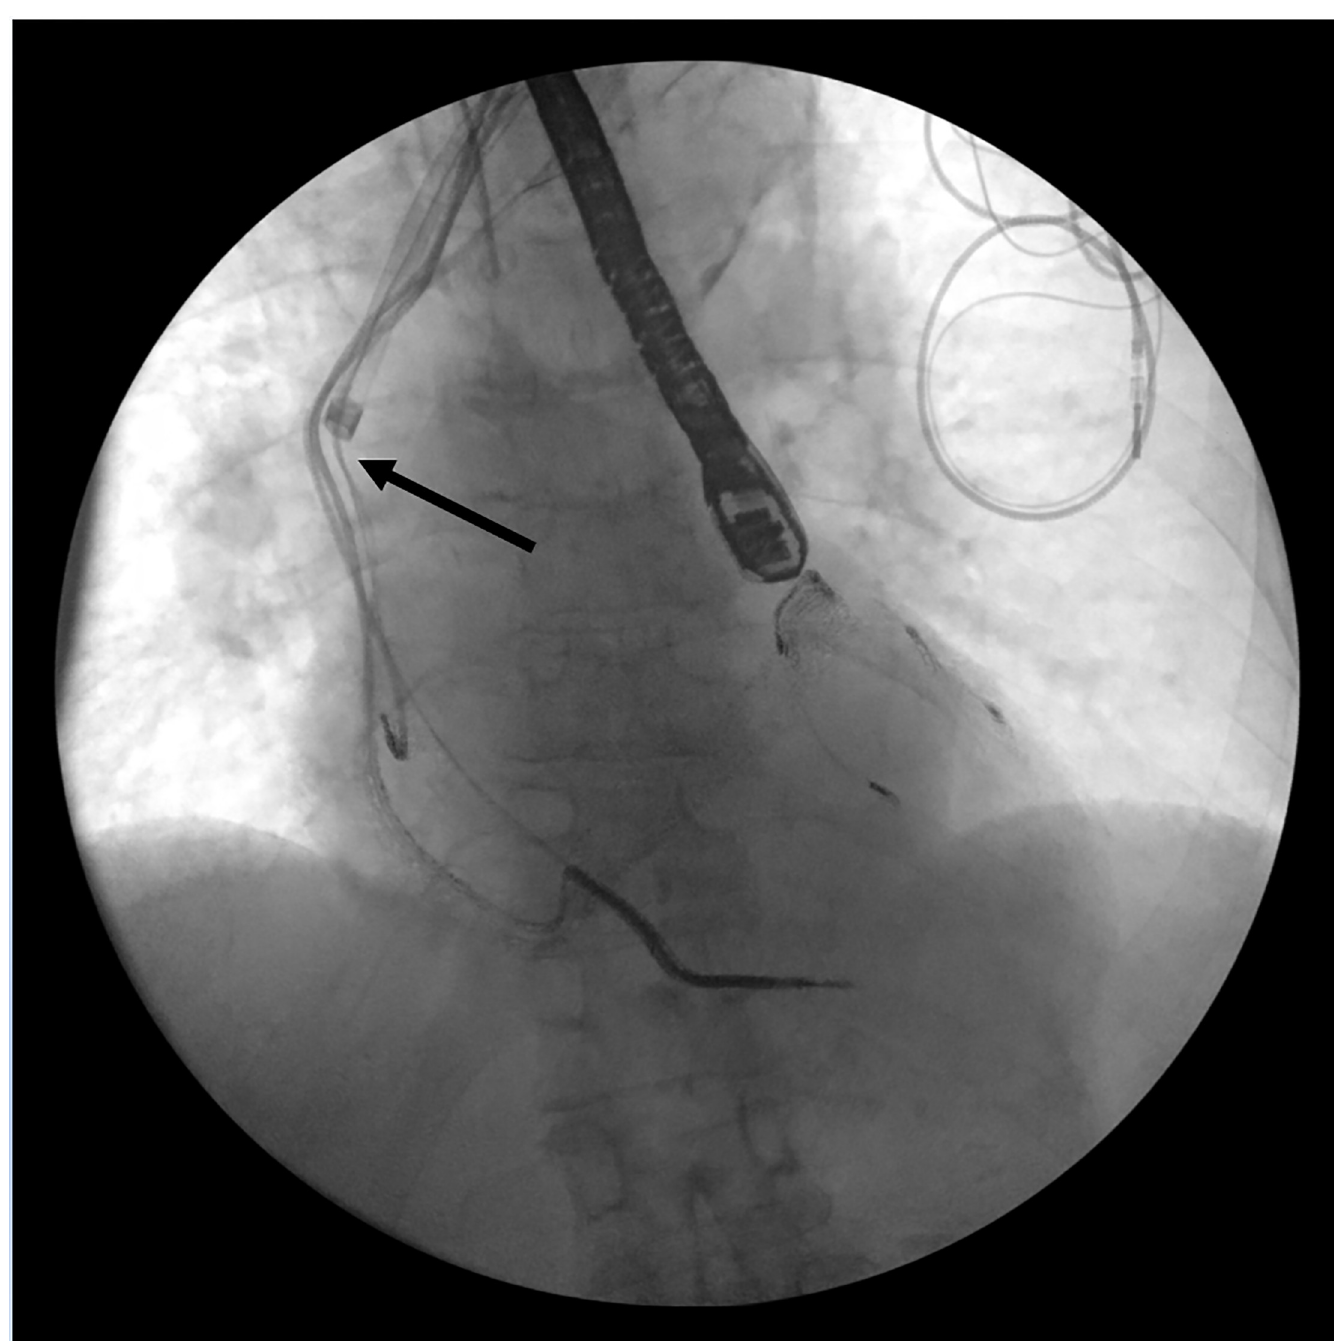
Fig 2. Advancing of the laser sheath over the lead marked by the